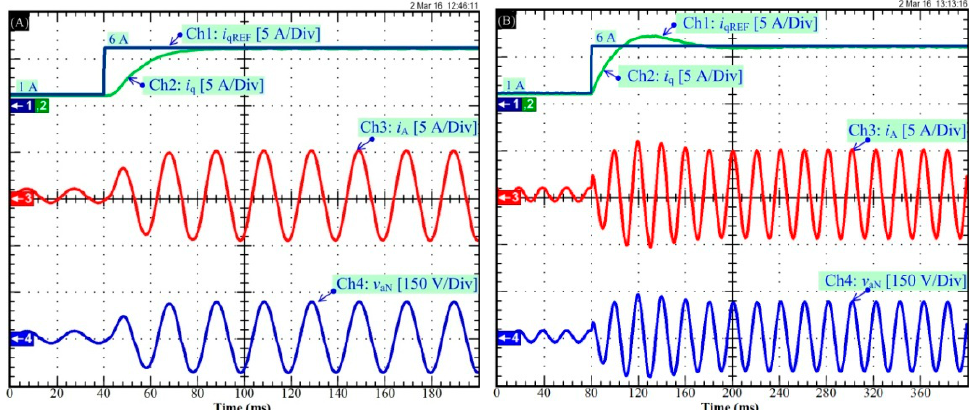
Figure 1. Experimental results: evaluation of current control of three-phase inverter drive during great changed current reference: ( A ) the differential flatness control; ( B ) a traditional PI regulation (vector control) [17].